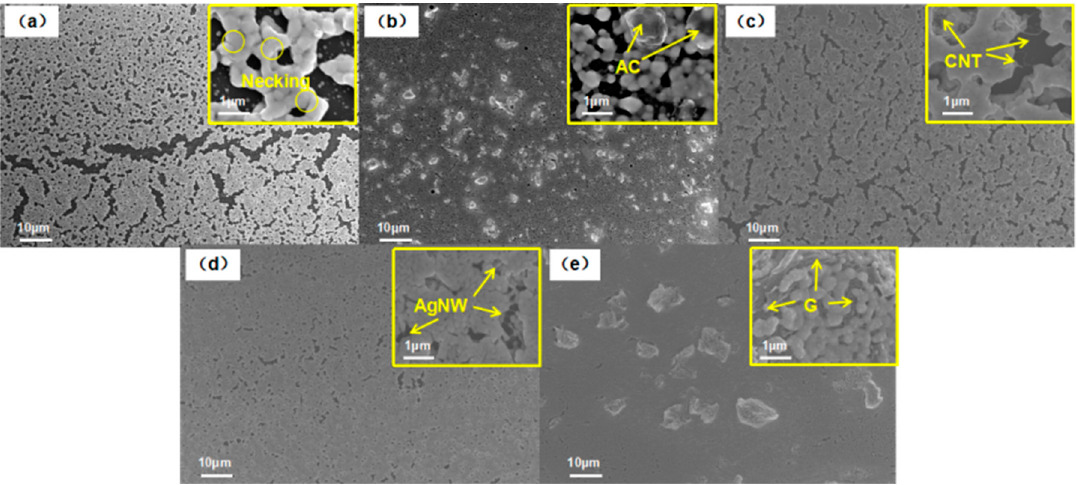
Figure 5. Scanning electron micrograph of sintered electrodes with: ( a ) AgNP; ( b ) AgNP/AC; ( c ) AgNP/CNT; ( d ) AgNP/AgNW; and ( e ) AgNP/G inks.